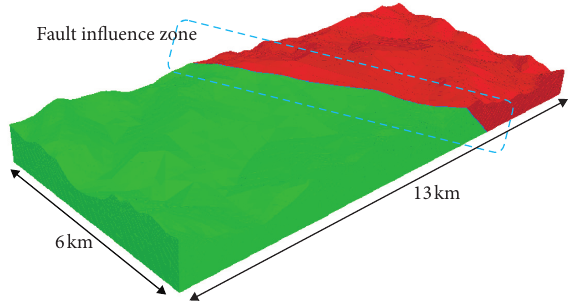
Figure 4: 3D numerical model.